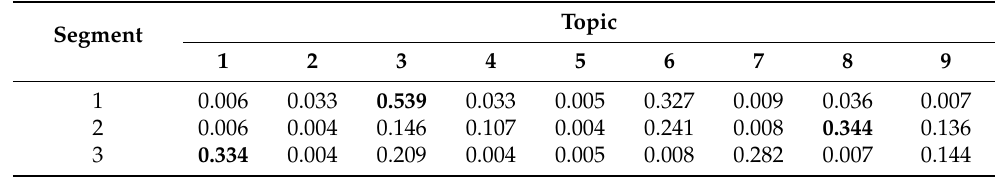
Table 6. The updated topic probability distribution of the segmented review (bold numbers indicate the highest probability for each segment).